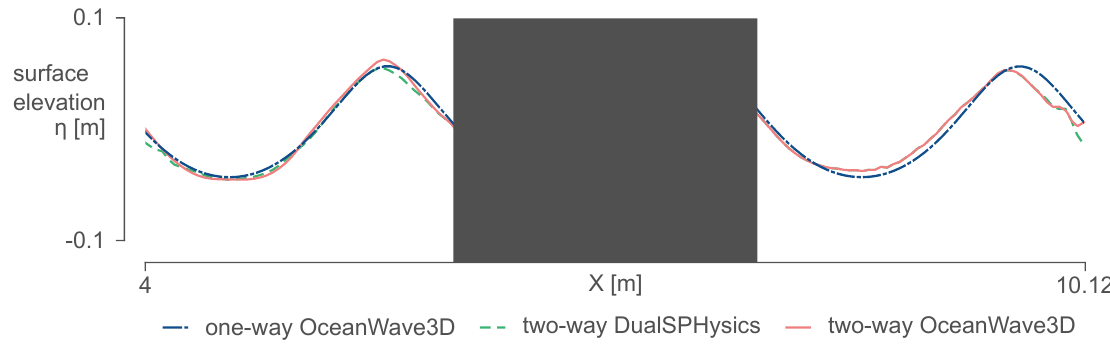
Figure 10. Comparison of the instantaneous surface elevation profile between one-way and two-way coupling results of OceanWave3D and DualSPHysics. The grey masked out zone is the region around the floating box, omitted from the coupling.